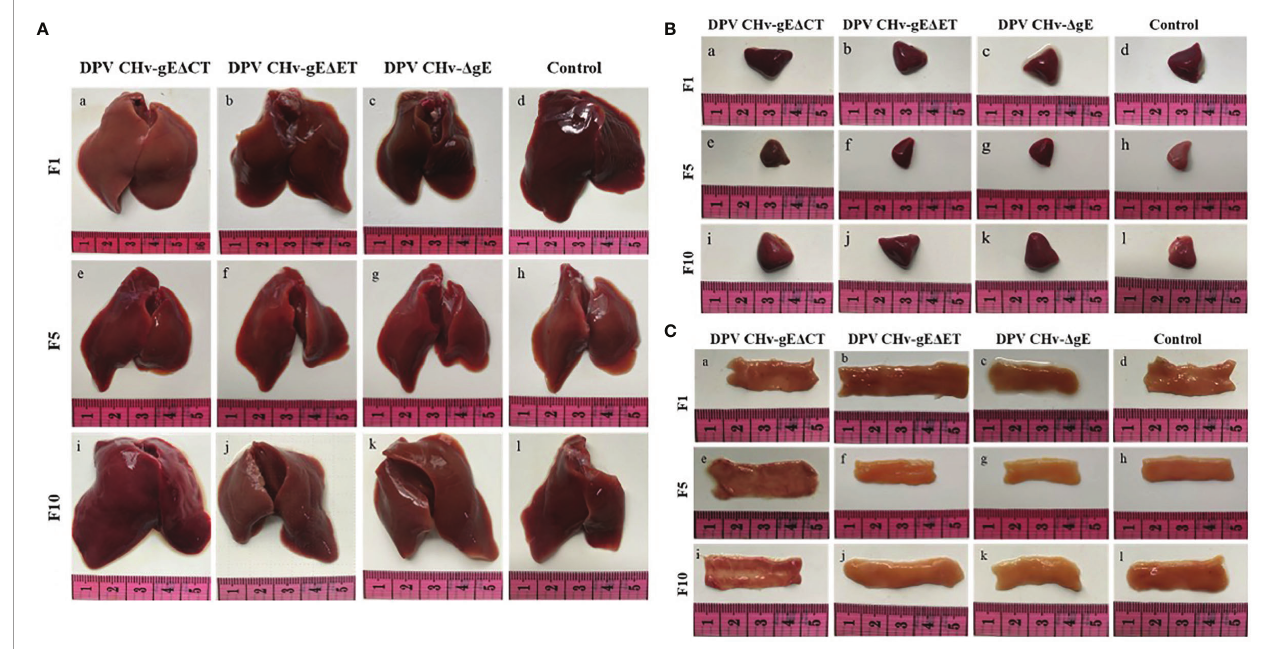
FIGURE 5 | Pathological lesions of ducklings after challenge with the mutant virus at passages 1, 5, and 10. (A) Liver; (B) Spleen; (C)